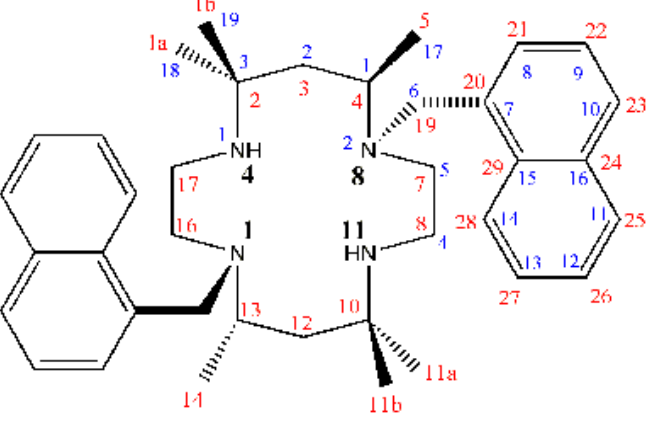
Figure 1. Structural representation of the 1,8-di-(1-methylnaphthalene) derivative of tet